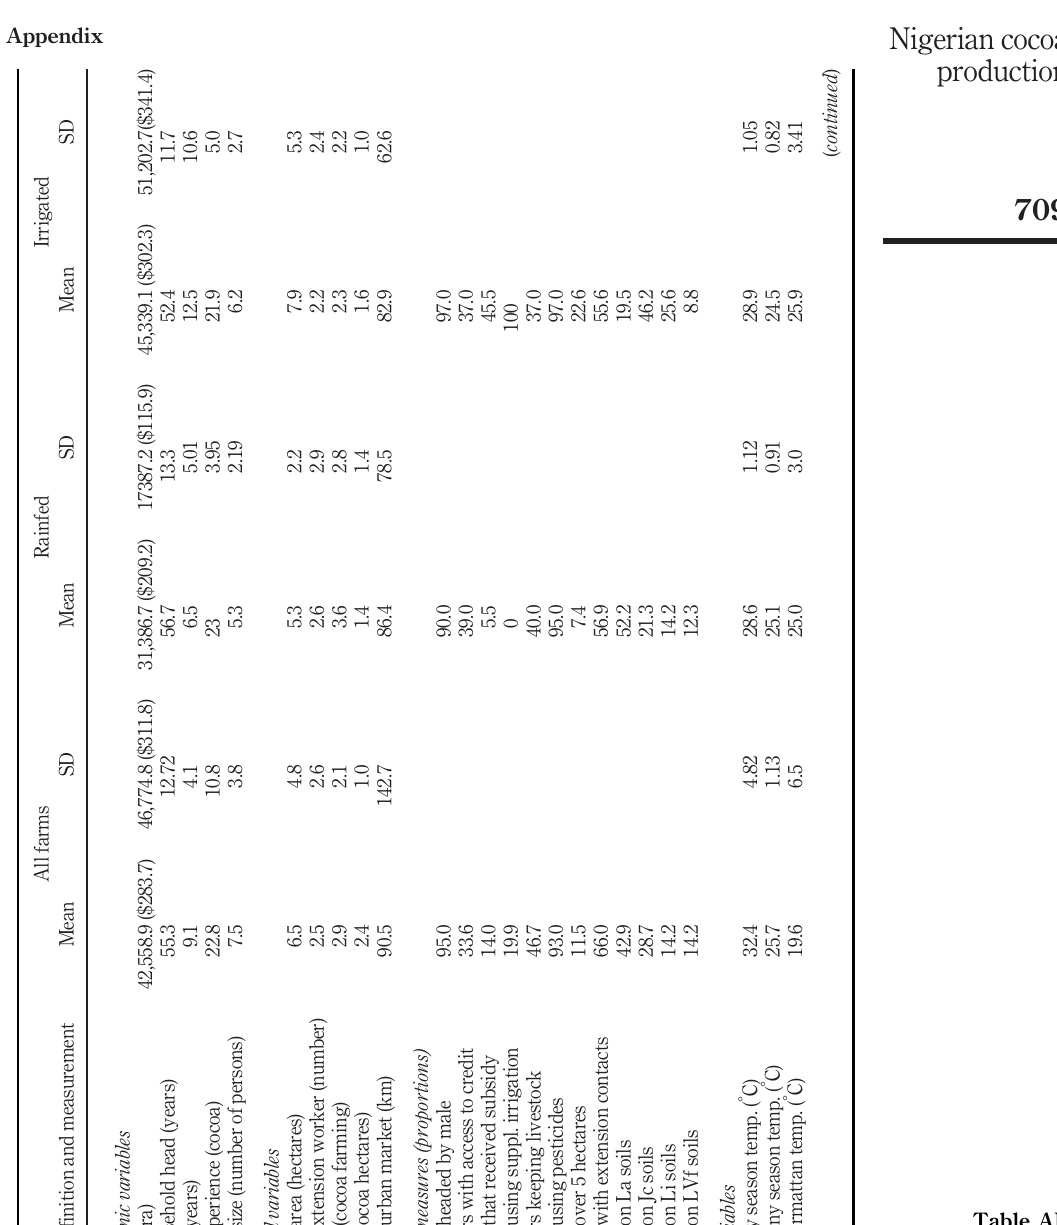
Table AI. Summary